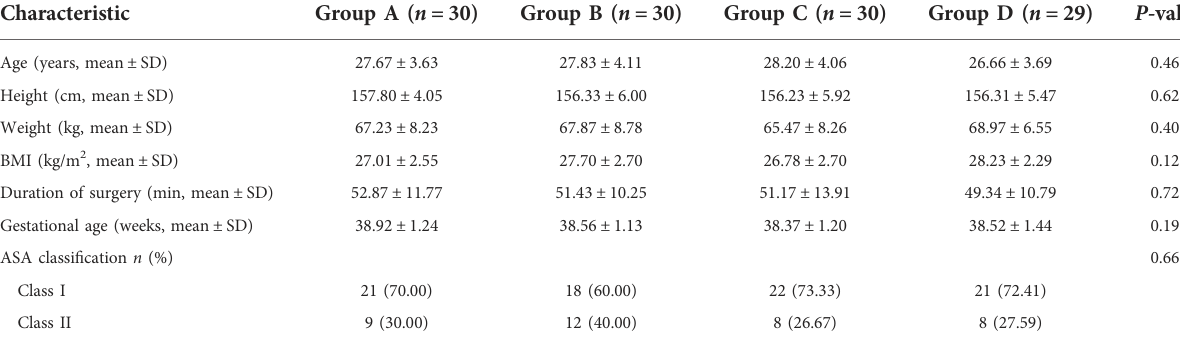
TABLE 1 The characteristics of the parturients enrolled in this study. Characteristic